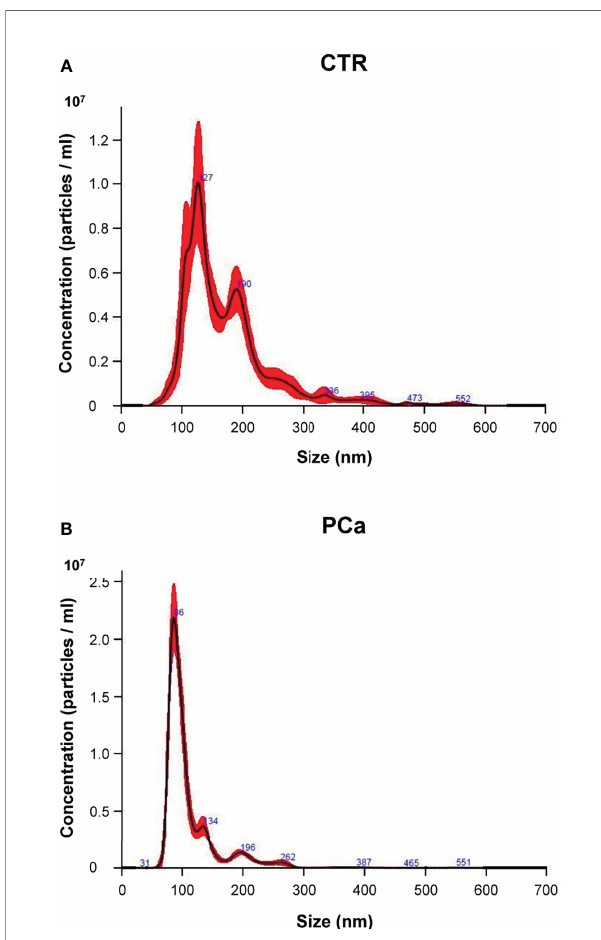
FIGURE 1 | Representative NTA distribution of plasma exosomes in CTR individuals (A) and PCa patients (B) .